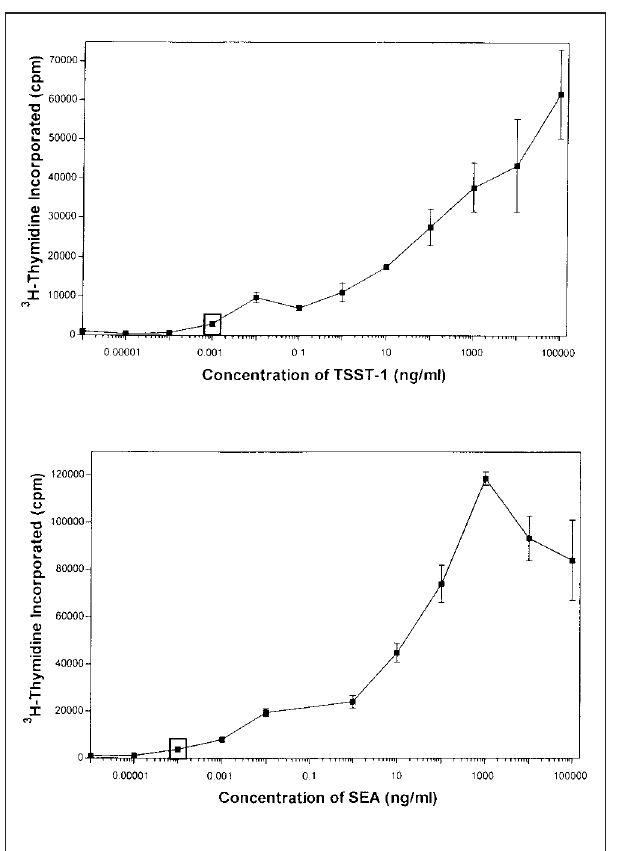
Figure 1) Dose-response relationship of different concentrations of